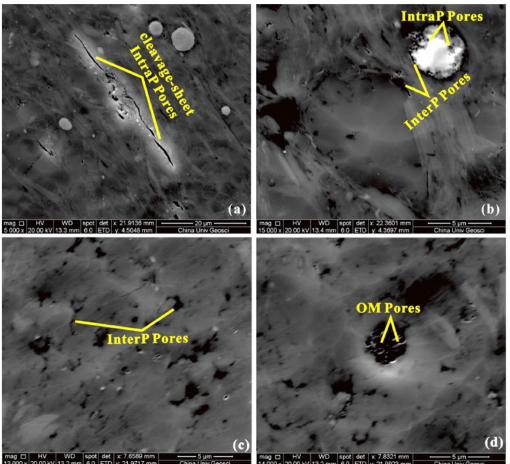
Figure 7. Pore structure characteristics of argillaceous shale in Niutitang Formation. ( a ) Cleavage- sheet intraparticle pores within clay minerals; ( b ) Intraparticle pores within pyrite framboids and interparticle pores between quartz and clay minerals; ( c ) interparticle pores between caly minerals and rigid grains; ( d ) organic pores in honeycomb